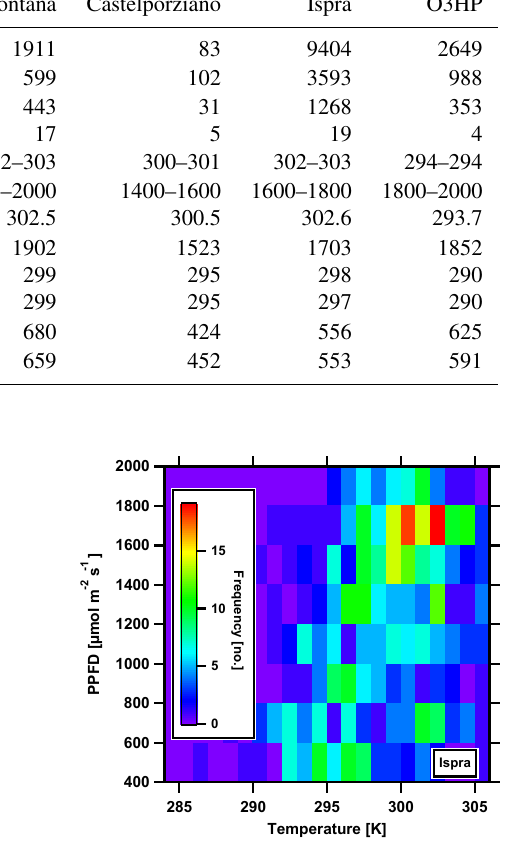
Figure 8. Two-dimensional histogram plot of flux averaging periods that correspond to bins of light ( 200µmolm − 2 s − 1 ) and temper- ± ature ( 1K) at the Ispra forest measurement ±